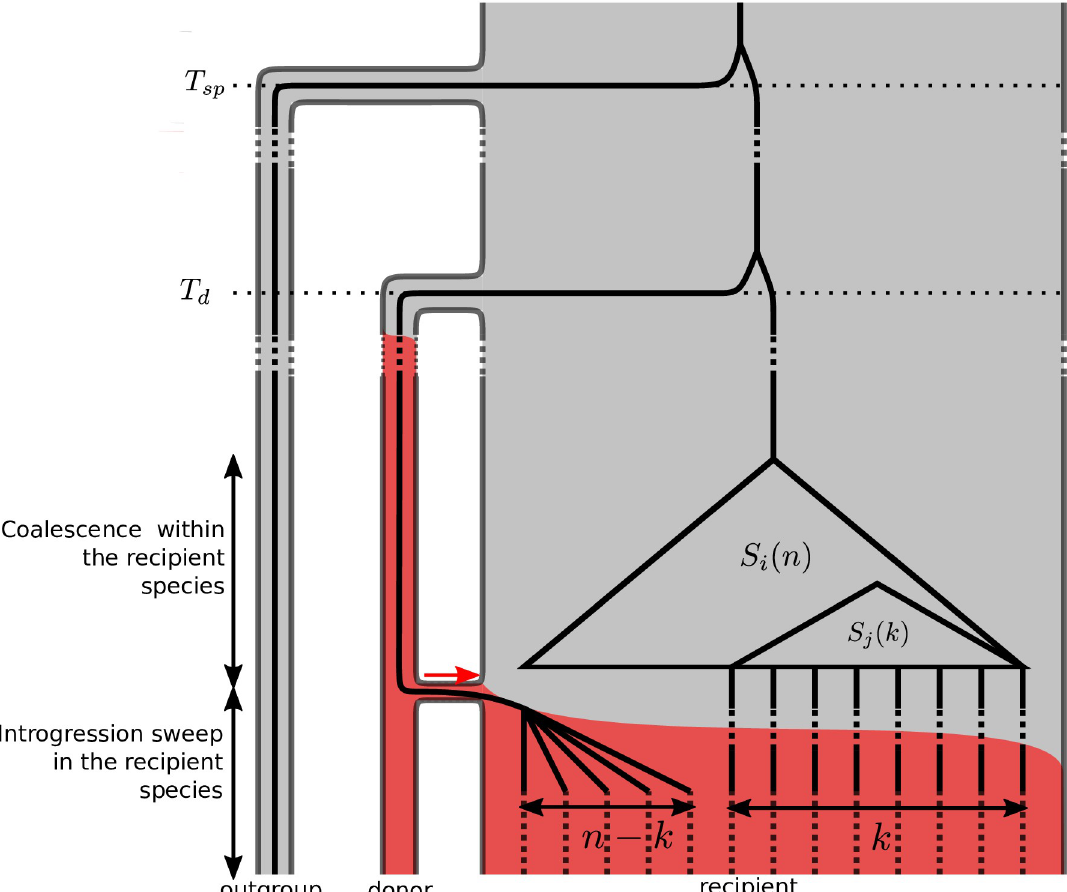
Fig 1. Model of an introgression sweep after a secondary contact. Species trees : phylogenetic relationships between the recipient, donor and outgroup species. Note that the time scale is not respected ( T d and T sp are very large) and that all species are assumed to have the same size. Coloured background : frequency of the selected allele in the different species. A single favourable haplotype is introduced into the recipient species through a rare hybridization event with the donor (red arrow) where it eventually reaches fixation. Superimposed coalescent tree : coalescent tree of a sample of n lineages, taken from the recipient population at a neutral site located at a distance d from the focus of selection. k lineages escape the selective sweep (see Eq (2)) and their polymorphism is a subsample of the neutral site frequency spectrum (see Eq (6)). The other n − k lineages trace back as a single lineage into the donor species.